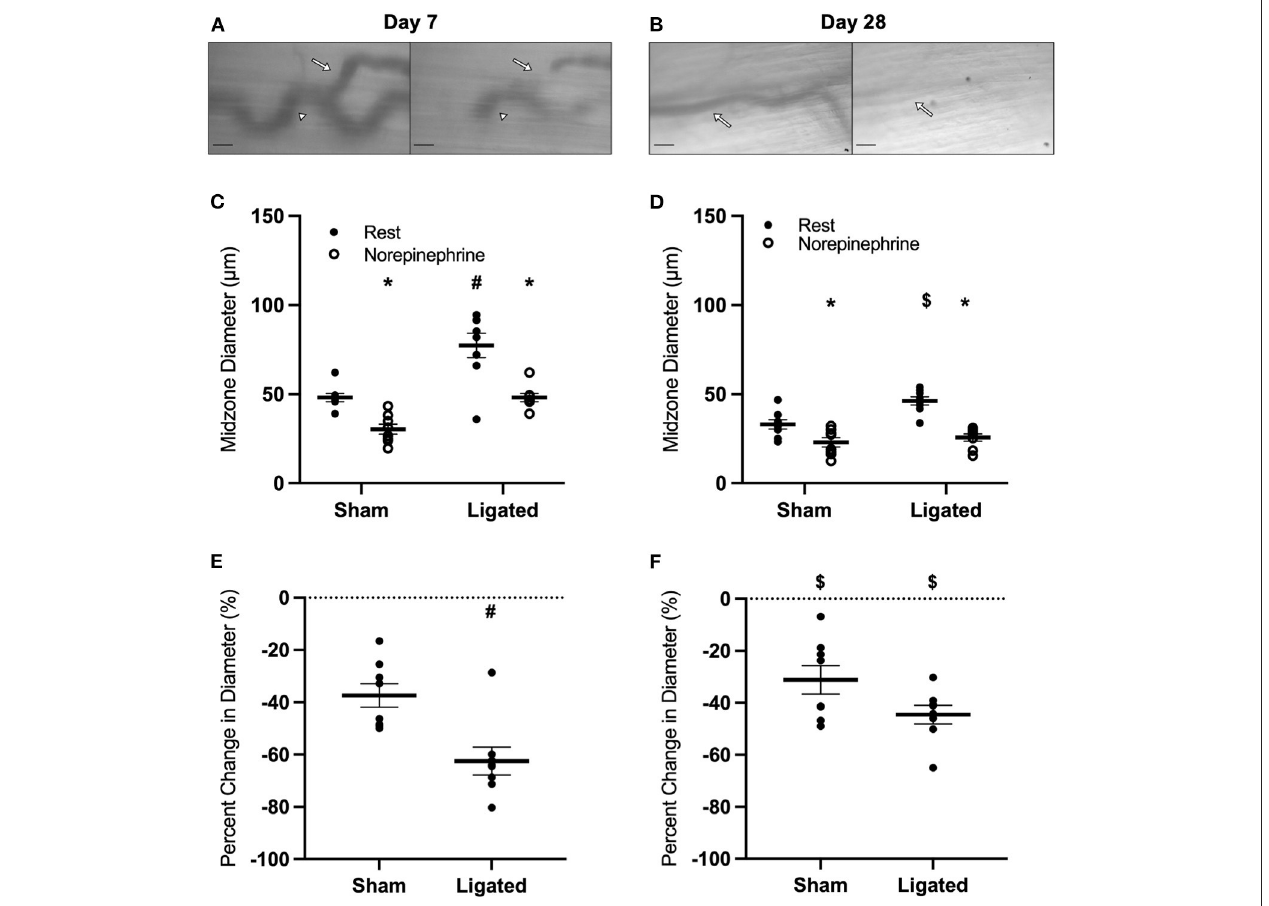
FIGURE 5 | Collateral vessels are normal to hypersensitive to α -adrenergic stimulation at day 7, but not day 28. Collateral vessels were observed at the collateral midzone by intravital microscopy with transillumination at 7 days (A) or 28 days (B) post-femoral artery ligation in the left mouse hindlimb at rest (left) and following exposure to 10 − 4 M of α -adrenergic agonist norepinephrine (right); regional heterogeneity in the enlarged collateral arteriole to α -adrenergic activation at day 7 is indicated by arrows (responsive, site of measurement) and arrow heads (unresponsive) and scale bar represents 100 µ m. While α -adrenergic stimulation vasoconstricts collaterals at both day 7 ( C , n = 8) and day 28 ( D , n = 8), enlarged collaterals appear to be hypersensitive at 7 days (E) , but not 28 days post femoral artery ligation (F) . * p < 0.05 vs. resting, # p < 0.05 vs. sham, $ p < 0.05 vs. day